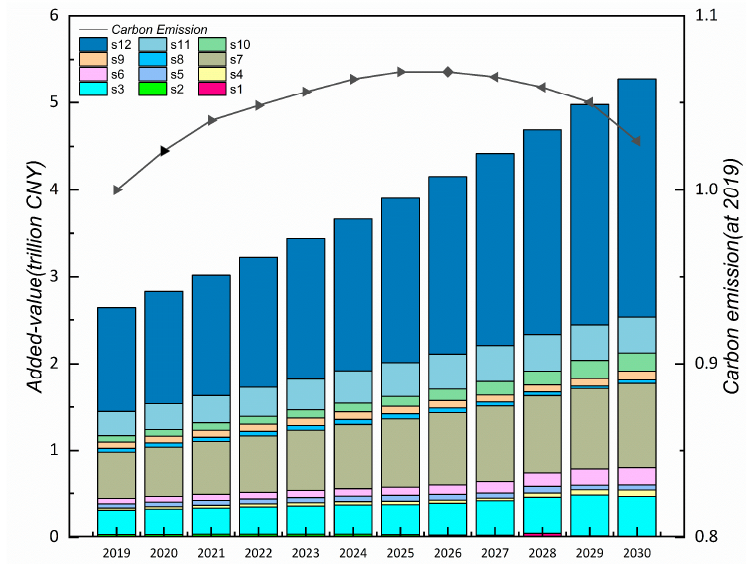
Figure 1. The carbon peak path of economic structure adjustment in Shenzhen from 2019 to 2030. The X -axis represents the added value of industries (in units of CNY 1 trillion); the Y -axis represents the relative value of carbon emissions with 2019 as the base year; the direction of the solid triangle highlights the trend of emissions growth, and the inverted diamond indicates that carbon emissions have reached the peak level.